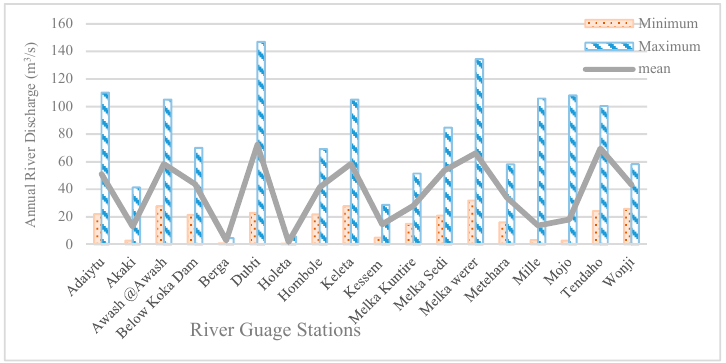
Figure 8. The annual river discharge of ARB at 18 stations .